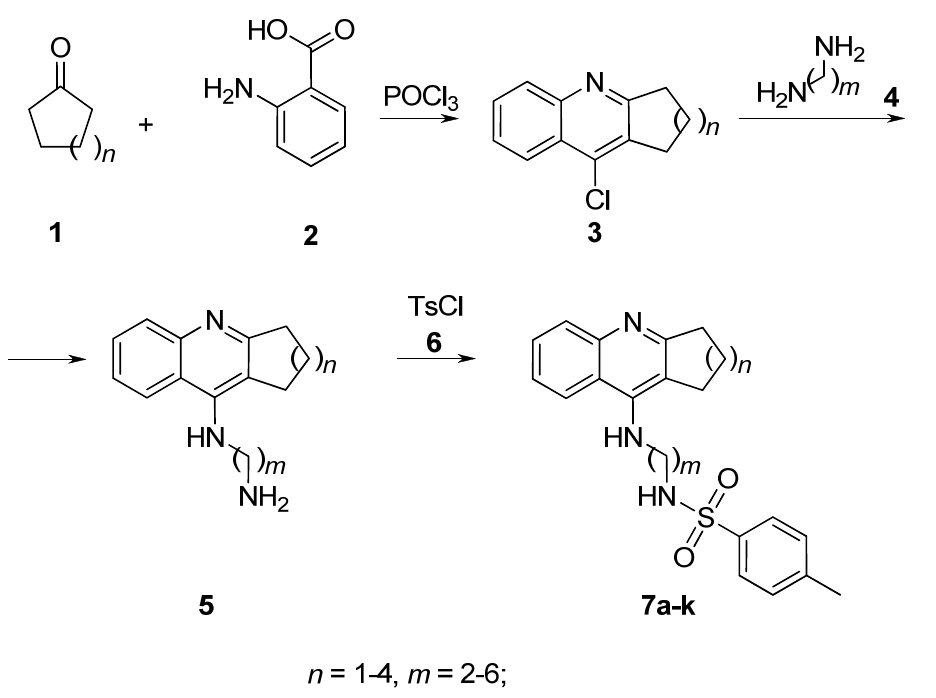
Figure 2. Synthesis of conjugates of 4-amino-2,3-polymethylene-quinolines and p -tolylsulfonamide 7 . Thus, conjugates 7 with di ff erent sizes of the aliphatic ring of 4-amino-2,3-polymethylene- 2.2. Inhibition Studies of AChE, BChE and CES. Structure-Activity Relationships quinolines and various lengths of the alkyl chain linking the two pharmacophores have been synthesized. The size of the aliphatic ring and the length of the alkyl spacer for each compound 7 are shown